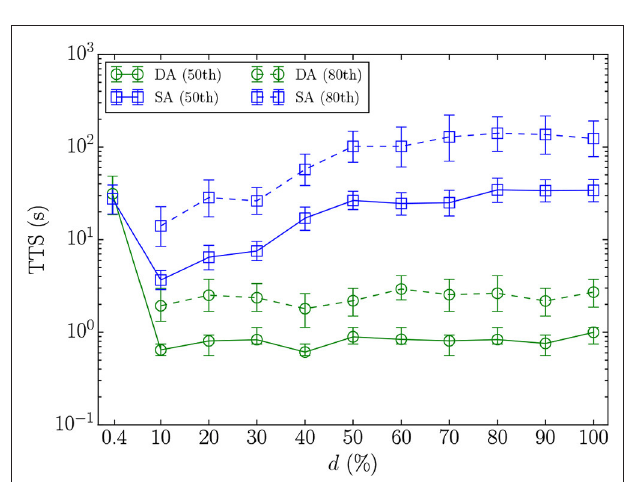
FIGURE 10 | Mean, 5th, and 95th percentiles of the TTS distributions (TTS 50 and TTS 80 ) for spin-glass problems with different densities ( d